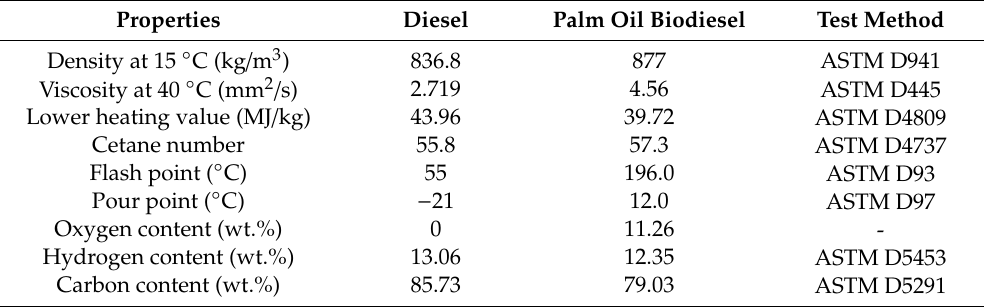
Table 1. Properties of test